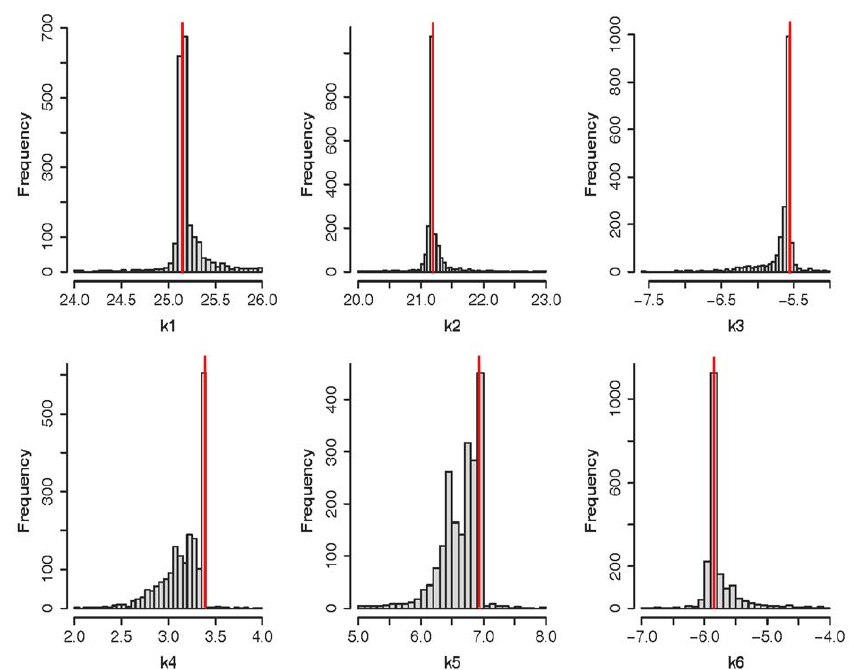
Figure 7. Histograms of calibrated parameter values. Horizontal axis shows the sampled range for each parameter, and the vertical axis represents the amount of parameter sets in each of the classes used to divide the horizontal